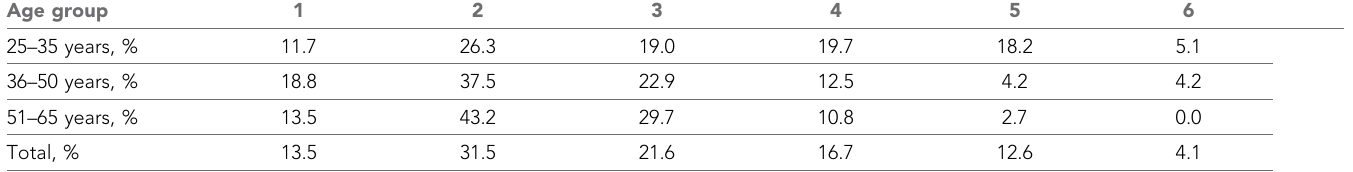
Table 4. Degree of identification with the work ethic portrait ’I often think I would be more successful if I gave up certain pleasures’, by age group Age group